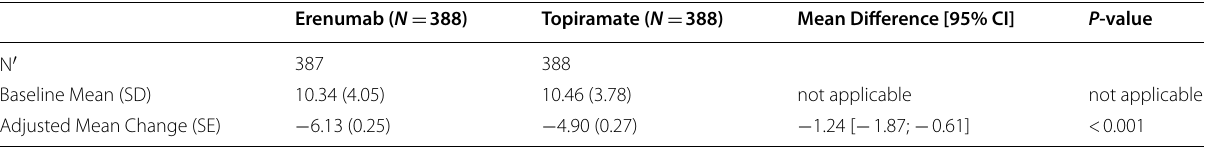
Table 1 Change from baseline in mean MMD over the last 3 months of the DBTP